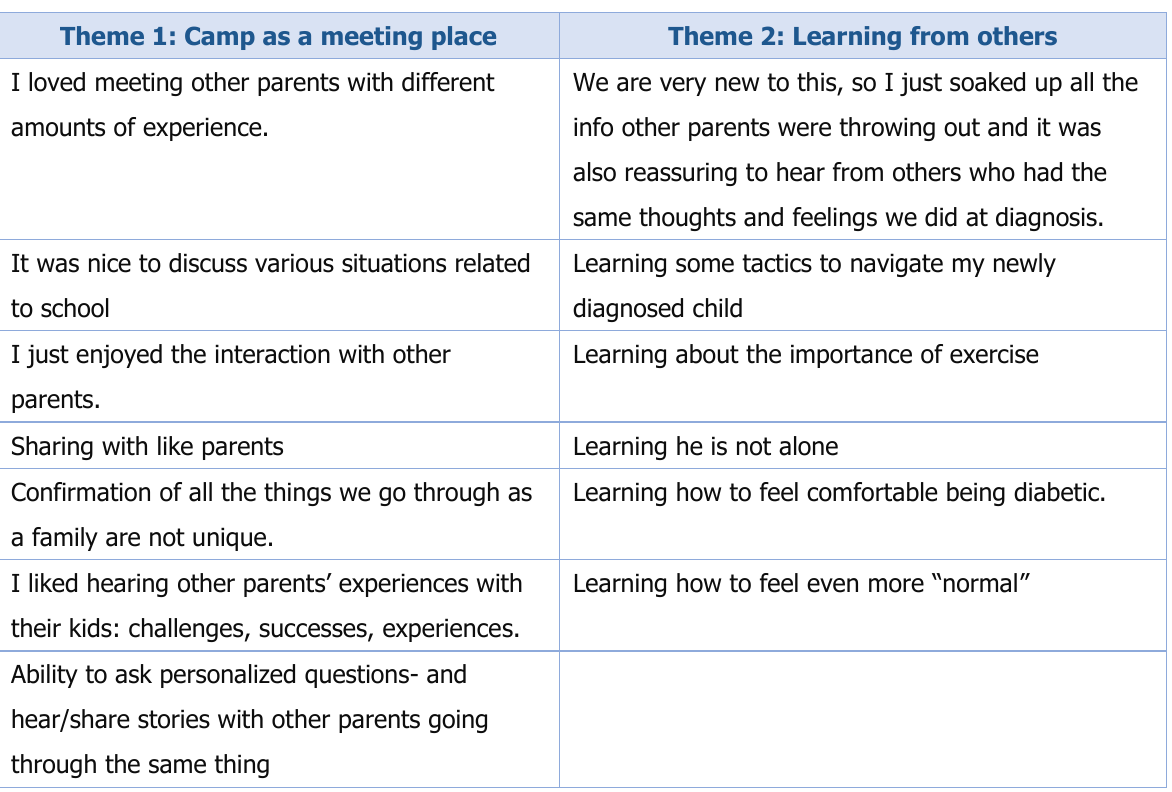
Table 1. Example Quotes Supporting Qualitative